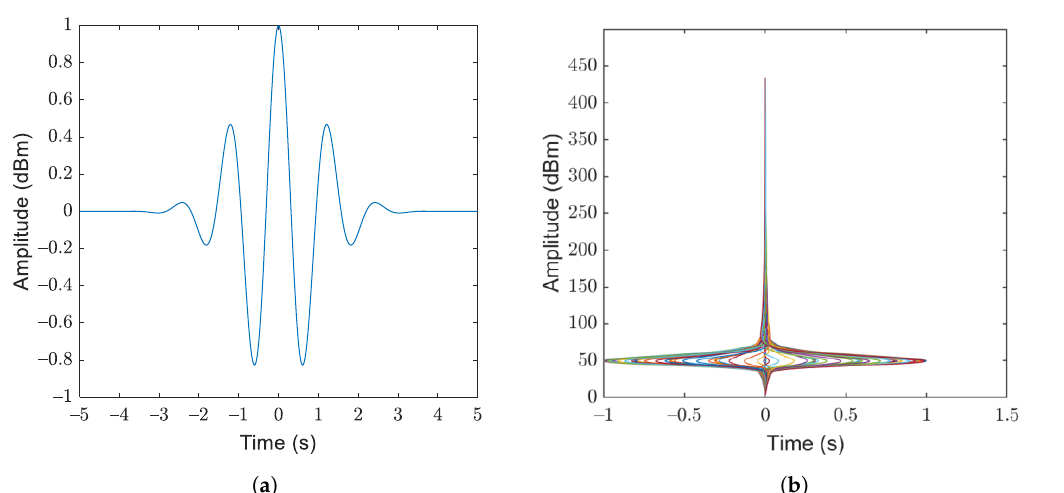
Figure 1. ( a ) A standard Morlet mother wavelet. ( b ) A standard Morse mother